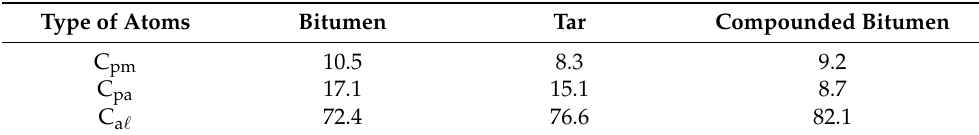
Table 9. Functional groups (% under quantity of 13